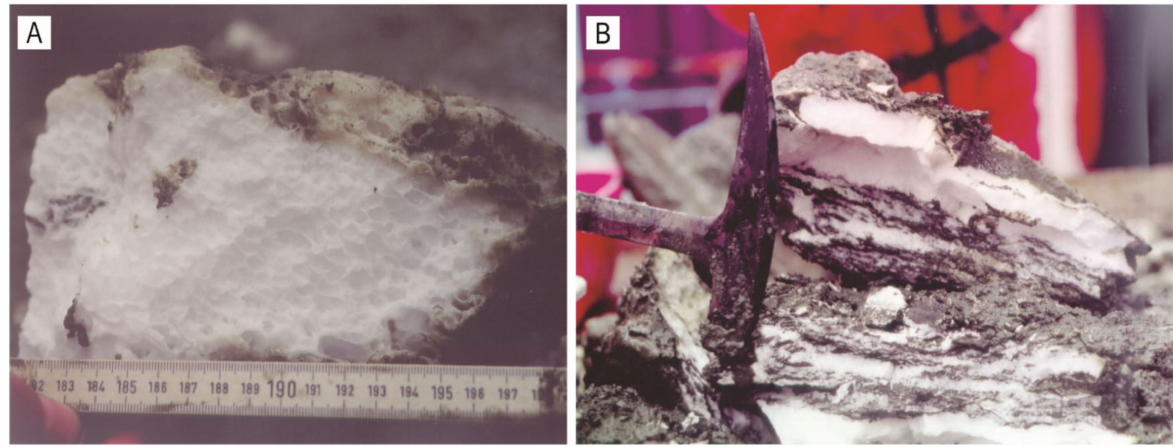
Figure 21. ( A ) Porous hydrates near the seafloor; ( B ) massive hydrates with no visible pore space (cited from [109]).